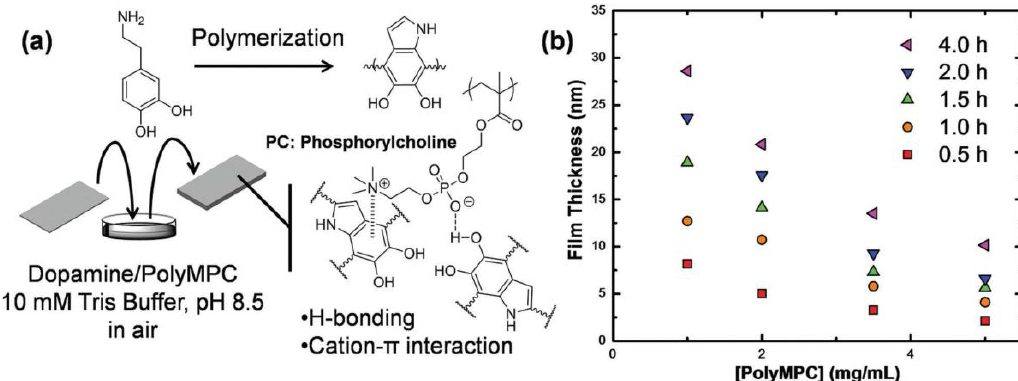
Figure 11. ( a ) Schematics showing the PDA- g -PMPC coating and the mechanism of the PDA-PMPC interactions; and ( b ) the effect of PMPC content and coating time on the coating thickness.